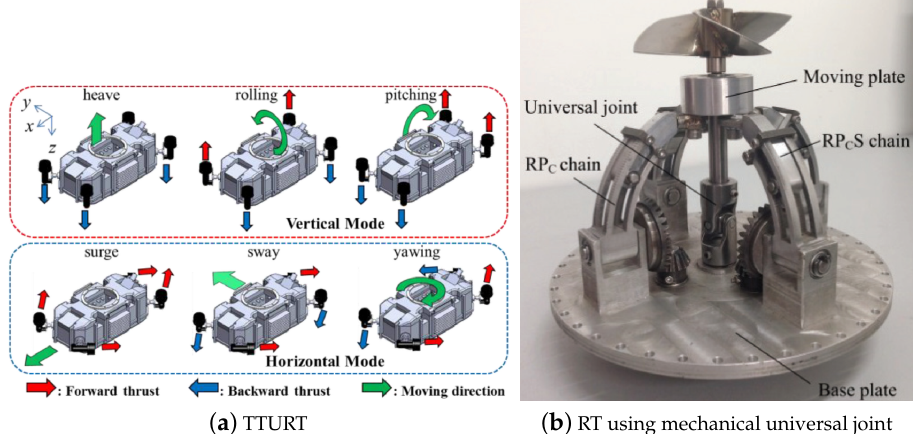
Figure 14. Two different RT architectures [63,64].